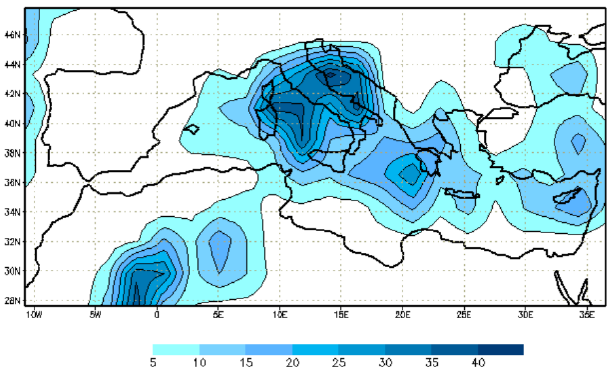
Figure 1. Number of intense cyclones over the 45 years of the ERA- 40 period at mature stage per squares of 2.25 ◦ × 2.25 ◦ . Reprinted from Homar et al.